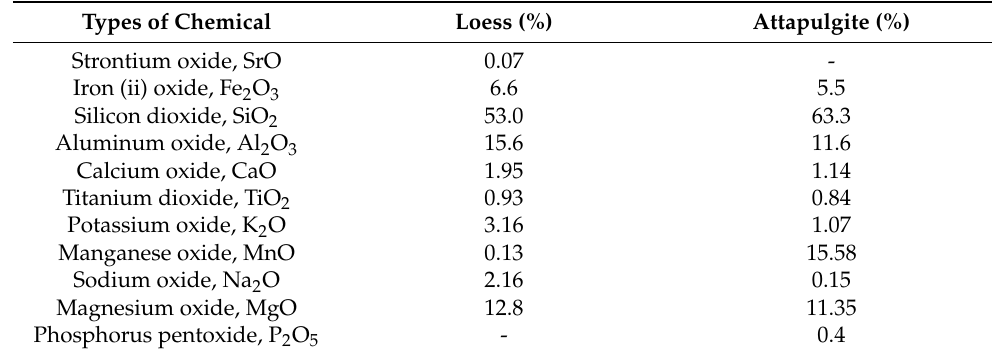
Table 2. The elemental chemical composition of loess and attapulgite. Types of